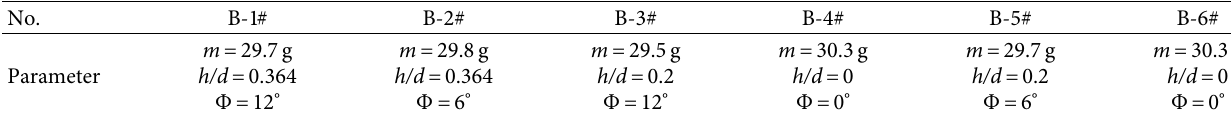
Table 2: Test conditions.